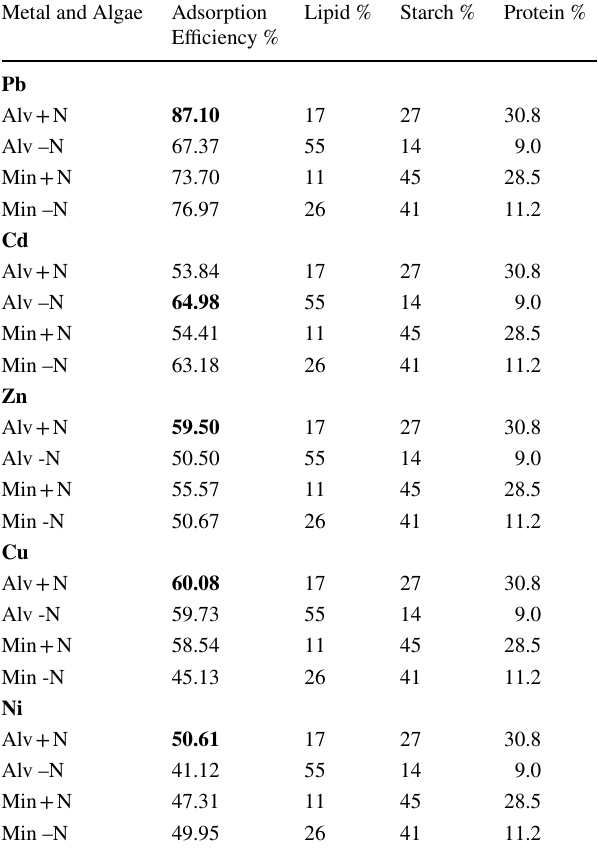
Fig. 5 Effect of initial ion concentration on the adsorption efficiency of Ni 2+ onto N. alveolaris + N, N. alveolaris –N, N. minuta + N, and N/ minuta –N algae Table 2 The maximum adsorption efficiency % of the lowest concen- tration metal ions tested with each algae and their biomass compo- sition: Neochloris alveolaris + N ( Alv + N), Neochloris alveolaris -N ( Alv -N), Neochloris minuta + N ( Min + N), and Neochloris minuta